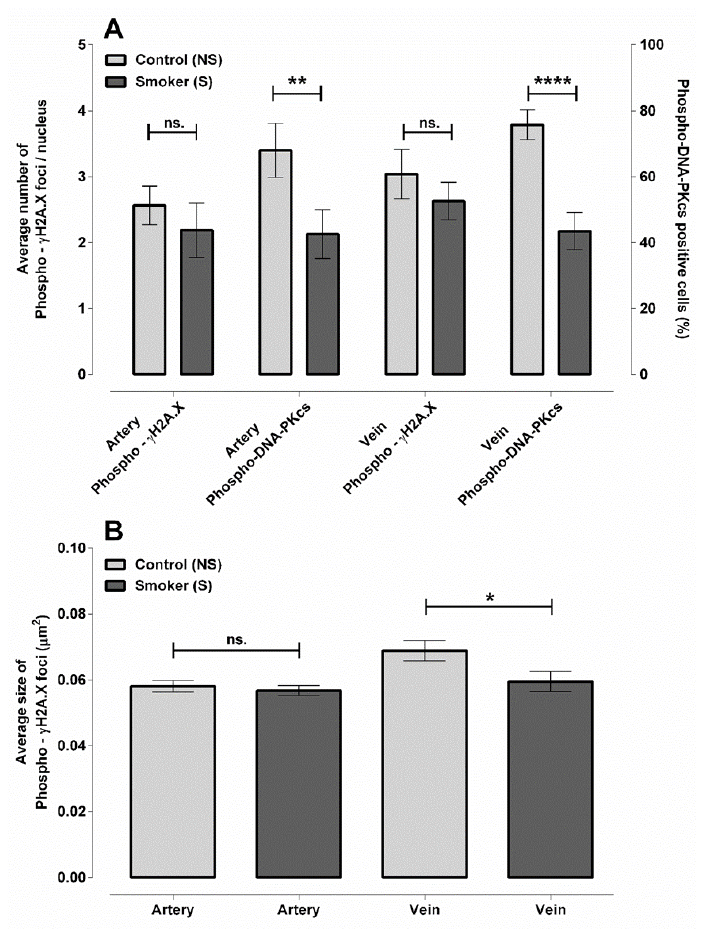
Figure 1. Analysis of DNA double-strand breaks and the efficiency of DNA repair in NS and S UC vessels. Graphical representation showing the quantitative analysis of phospho- ɤ H2A.X, phospho- DNA-PKcs ( A ) specific immunolabelling, and ɤ H2A.X focal mean size ( B ). Quantified regions and number of samples: NS (n = 101 arteries and 198 venous endothelial cell nuclei from 3 samples); S (n = 169 arteries and 189 venous endothelial cell nuclei from 3 samples). Statistical analysis was conducted by using two-way ( A ) and one-way ( B ) ANOVA followed by Holm–Sidak’s multiple comparisons test (ns. = not significant; * p ≤ 0.05; ** p ≤ 0.01; **** p ≤ 0.0001).